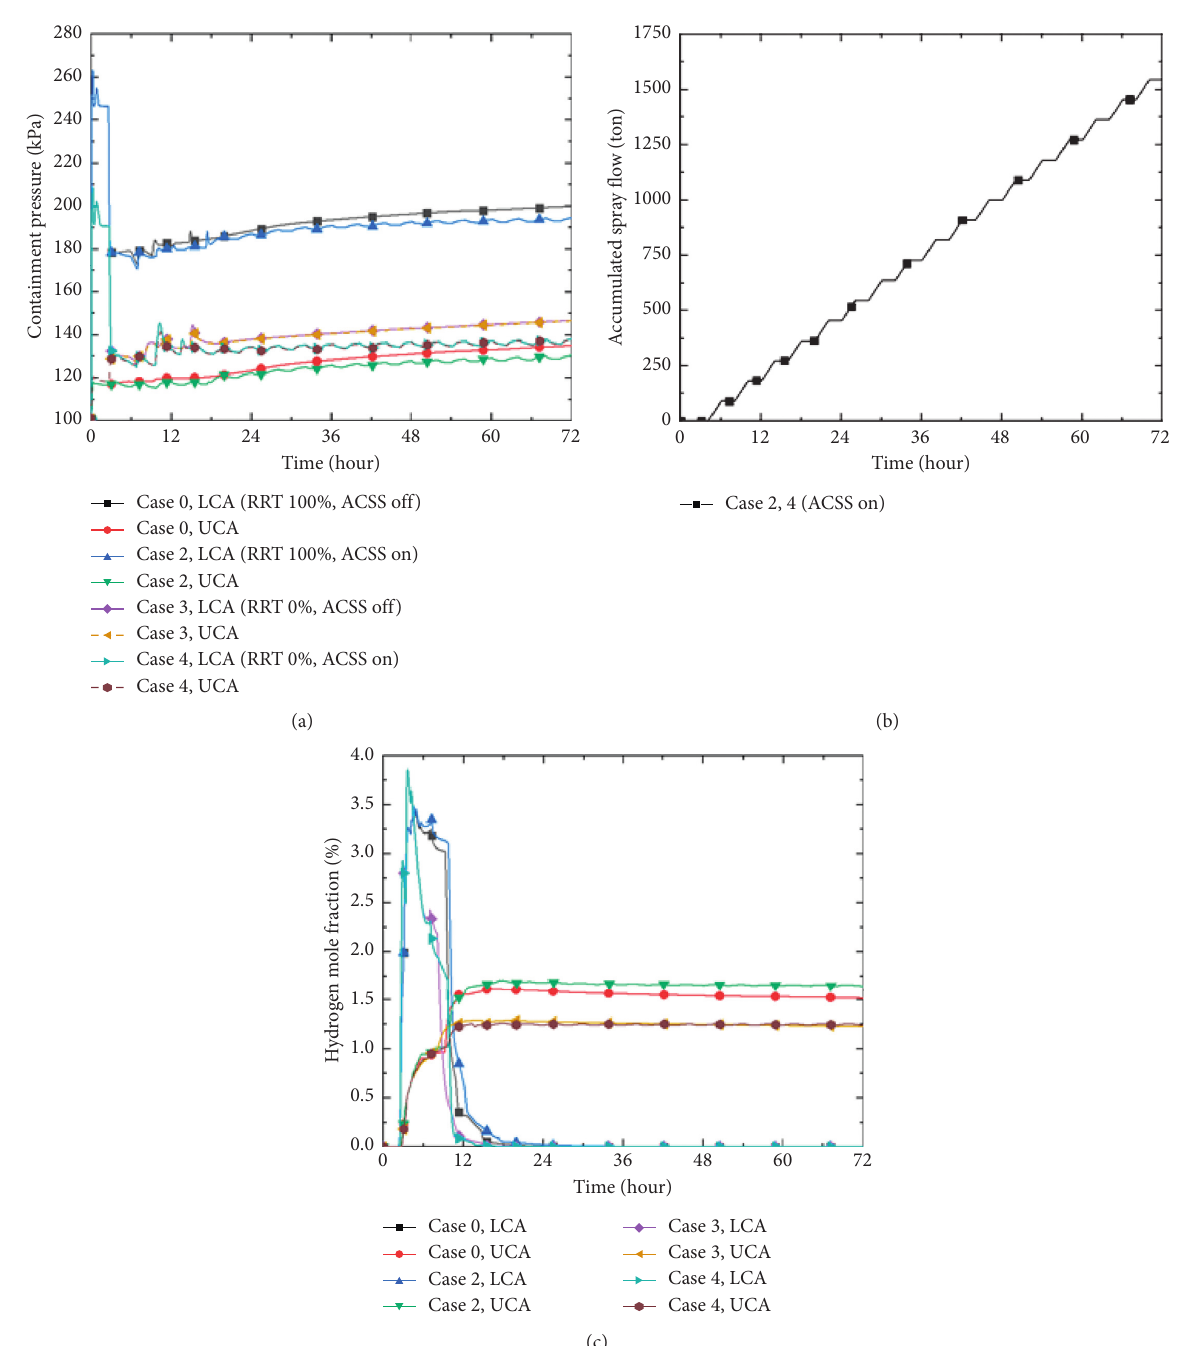
Figure 10: Containment properties from the MELCOR analysis: (a) pressure, (b) accumulated spray flow by the ancillary containment spray system, and (c) hydrogen mole